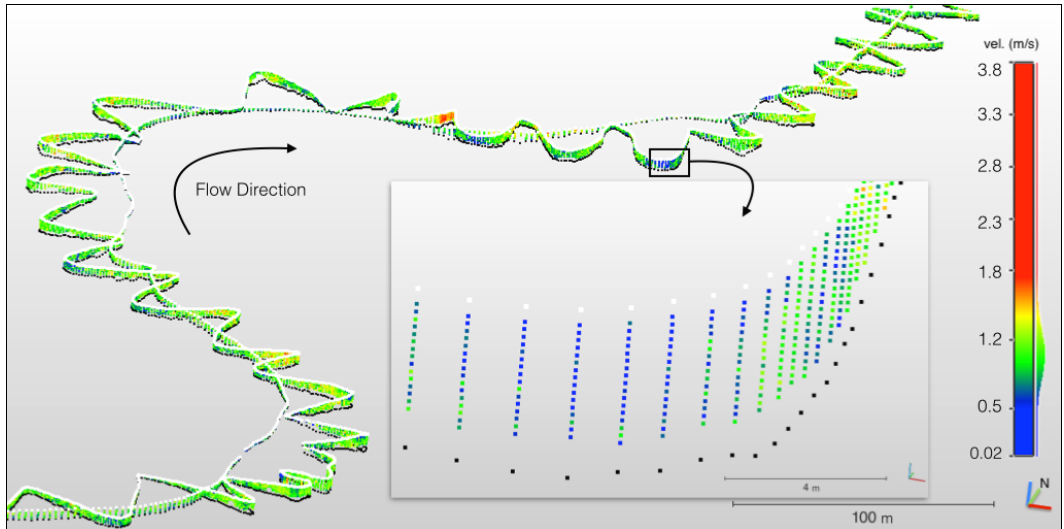
Figure 8. Point cloud of raw measured flow data from 18 May 2013, visualized in CloudCompare, looking downstream. The image shows a 800 m-long section of a 3.7 km-long measurement. The coloring represents flow velocity in m/s. The water